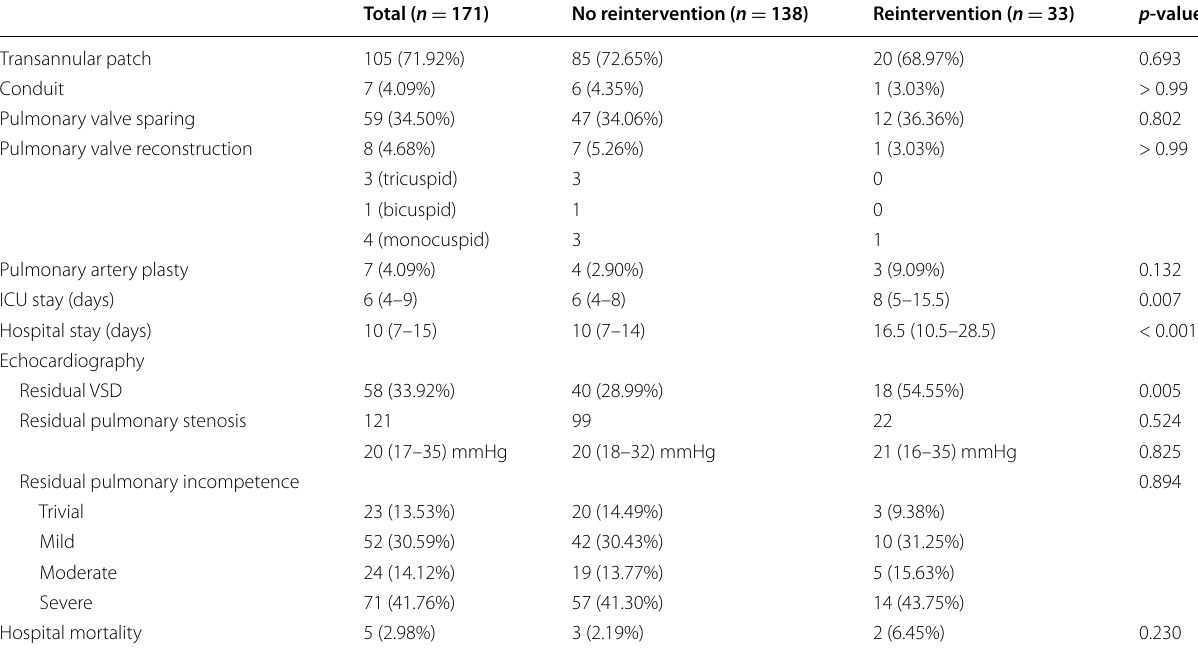
Table 2 Comparison of the operative and postoperative data between patients who had reintervention after tetralogy of Fallot repair vs. those who did